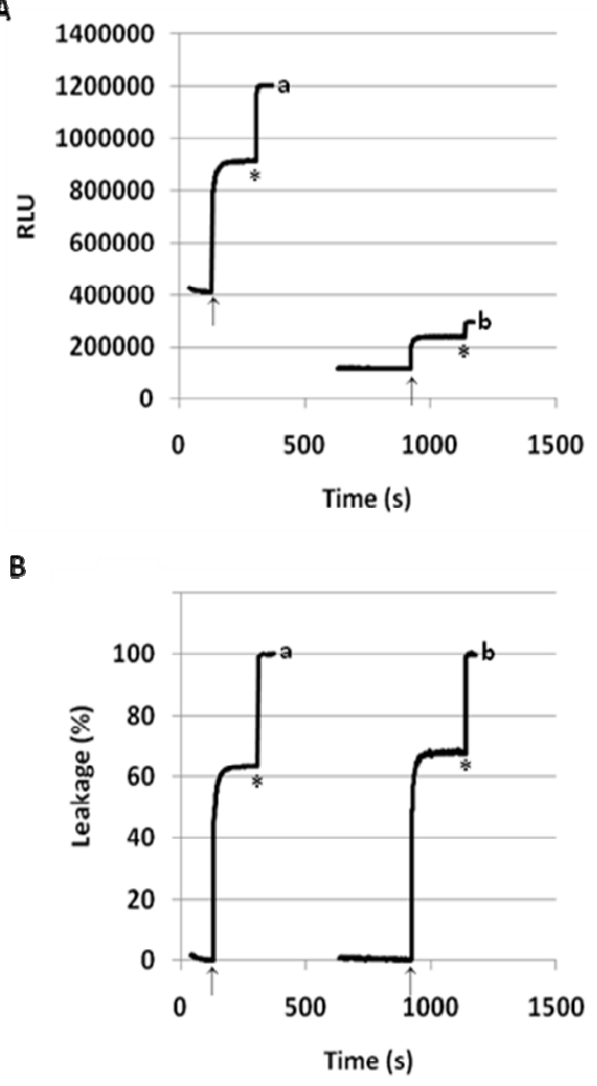
Figure 5. pH-triggered release of ANTS from 1 /POPC/PEG-ceramide fliposome (50/45/5) at (a) 0.12 mM and (b) 0.024 mM total lipid concentrations. Arrows: pH lowered from 7.4 to 5.1; asterisk: fliposome permeated by the detergent C ( A ) in relative light units (RLU), and ( B ) in percent of leakage. The x-axes are in relative time scales to fit all the traces into the